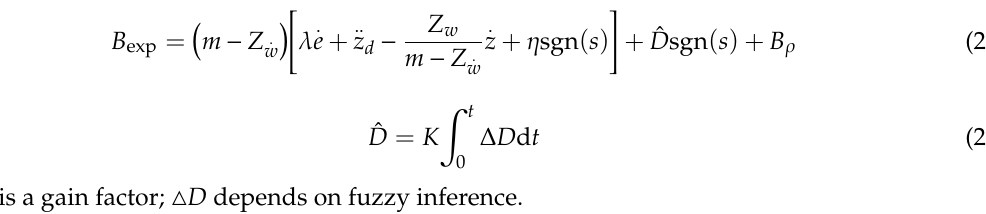
Figure 8. Block diagram of fuzzy sliding mode depth controller.